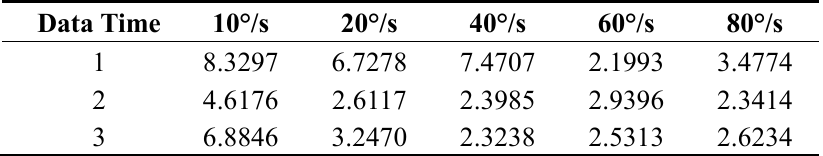
Table 2. Estimation results of the average ARW coefficient of x and z constant rate biased RLGs by utilizing the FOS-based